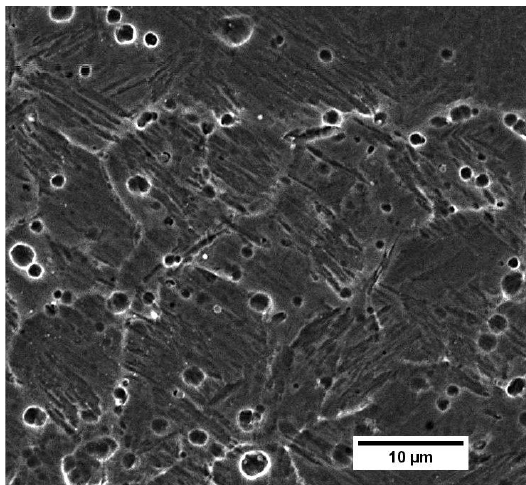
Figure 3. SEM observation of sample 8 (weld metal). Table 6. Full model coefficients.